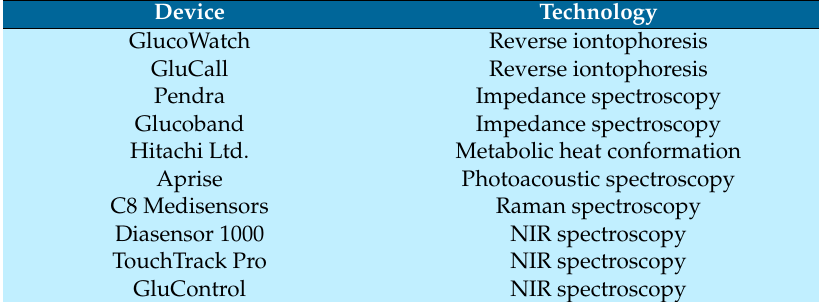
Table 23. List of commercial devices for non-invasive glucose monitoring never released or